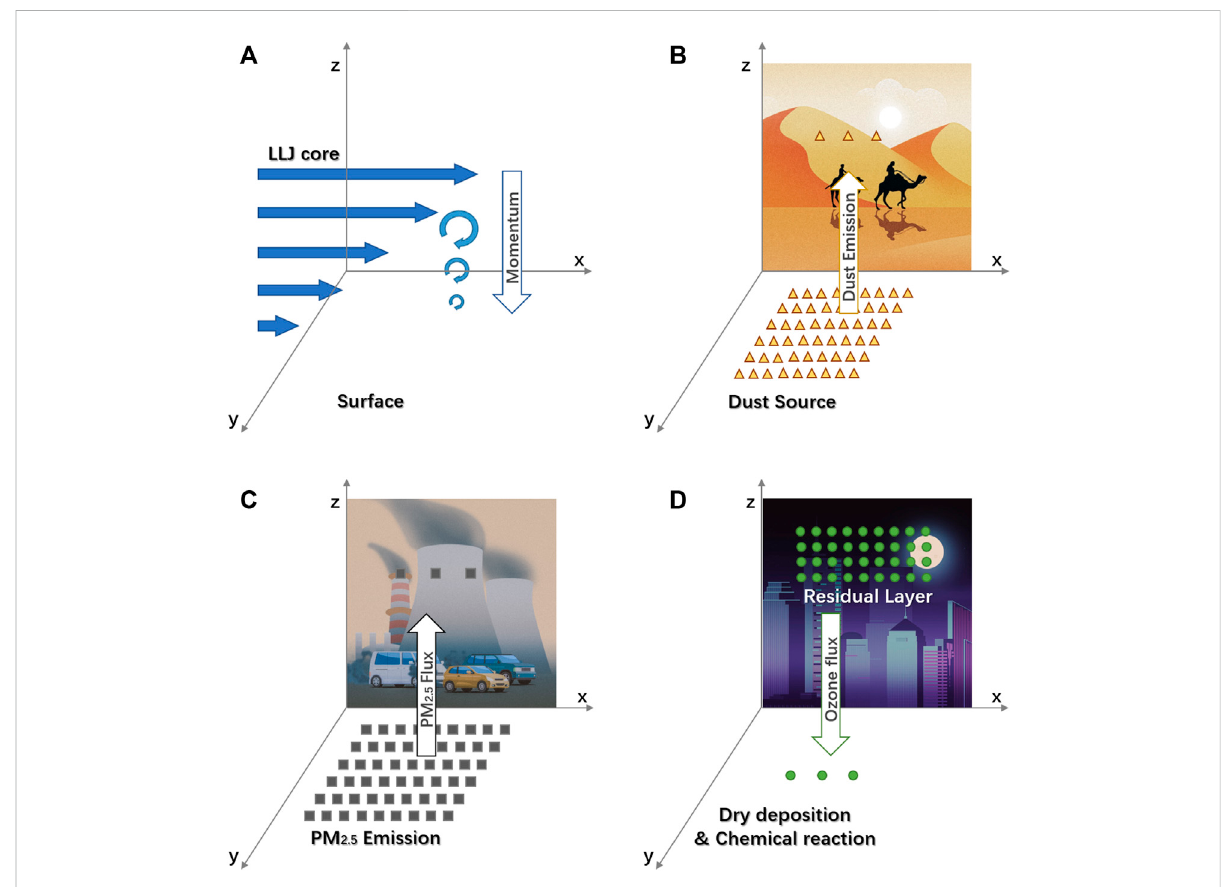
FIGURE 1 Schematic of vertical interaction between LLJs and pollutants with transport of (A) momentum, (B) dust, (C) fi ne particulate matter, and (D)